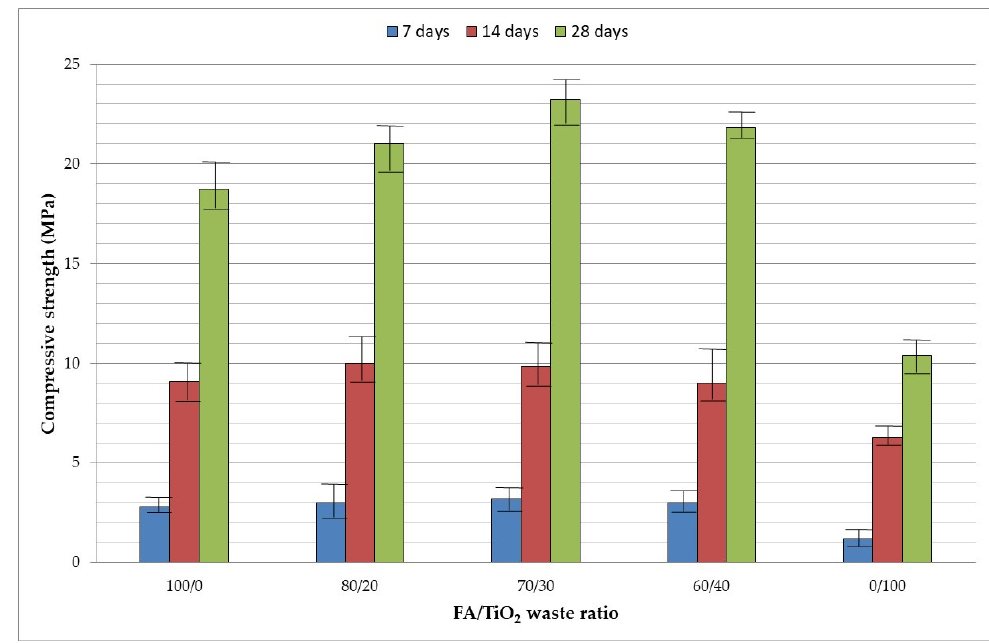
Figure 5. Compressive strength results.